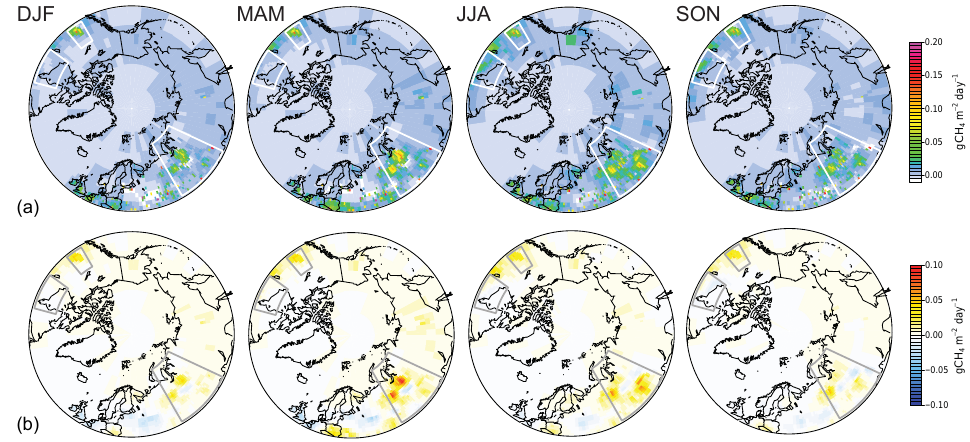
Figure 11. Mean posterior fluxes of CH 4 (a) and posterior–prior differences (b) shown for scenario S1 for winter 2008–2009 (DJF), spring 2009 (MAM), summer 2009 (JJA), and autumn 2009 (SON). (Units are gCH 4 m − 2 day − 1 )